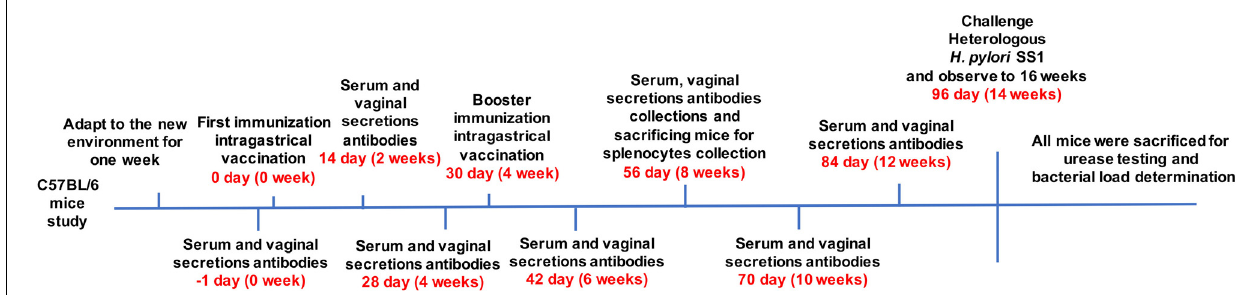
FIGURE 1 | Mice (6 weeks old, 16–22 g) were divided into groups of nine. Mice were immunized with various vaccines, OMPs or WCV by gavage. Booster immunizations were implemented at week 4. Blood samples and vaginal secretions were collected repeatedly and then mice were orally challenged with a lethal dose of H. pylori SS1 after booster immunization. The concentration of antibodies was determined at biweekly intervals after first immunization. Animal experiments were performed twice, and the data were combined for analysis.